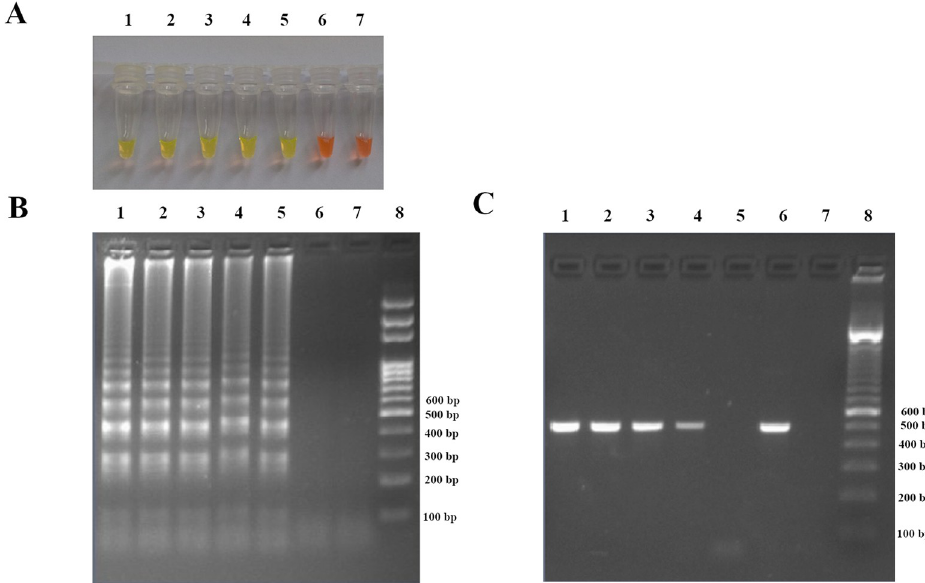
Fig 4. Detection limit of LAMP and PCR caf1 . Ten-fold serial dilutions of Y . pestis DNA extract were tested. (A) Visualization of color change by the naked eye. (B) Confirmation of results by agarose gel electrophoresis. Tubes and Lanes 1, 2, 3, 4, 5, 6, and 7: Y . pestis DNA extracts undiluted stock, 10 − 1 , 10 − 2 , 10 − 3 , 10 − 4 , 10 − 5 , and no DNA template (sterile distilled water) respectively, Lane 8: DNA ladder marker 100 bp. (C) Detection limit of conventional PCR caf1 . Lanes 1, 2, 3, 4, 5, 6, and 7: 10 − 1 , 10 − 2 , 10 − 3 , 10 − 4 , 10 − 5 , Y . pestis DNA extracts undiluted stock and no DNA template (sterile distilled water) respectively, Lane 8: DNA ladder marker 100 bp.